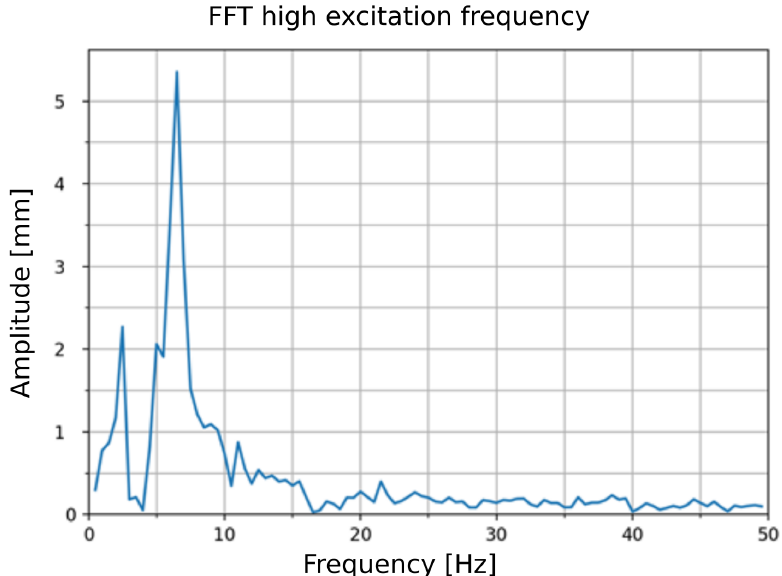
Figure 9. FFT Analysis with a large visible peak at 6.5Hz and a smaller peak visible at 2.5Hz which might be the two fundamental oscillation frequencies of the